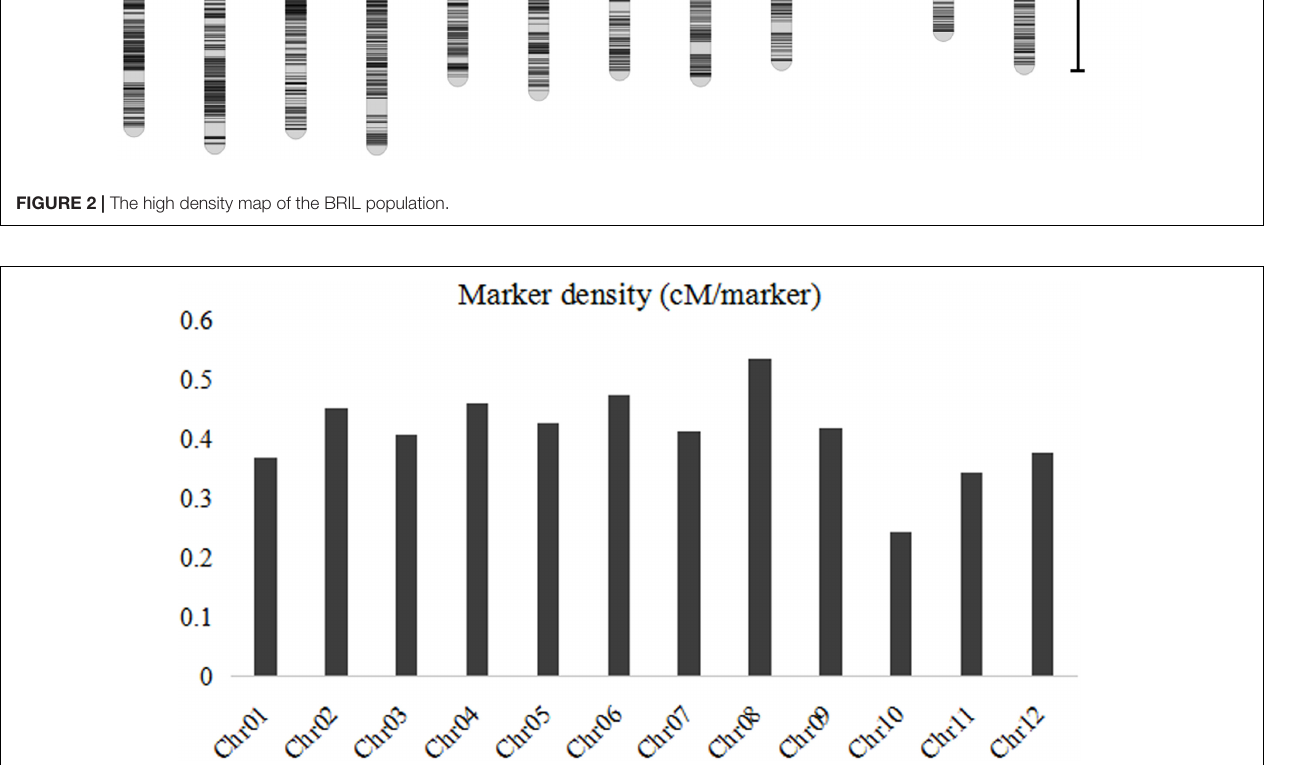
FIGURE 3 | The bin marker density for each chromosome in the BRIL